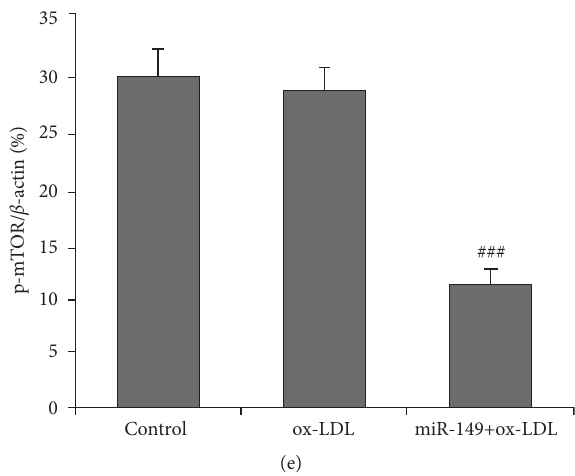
Figure 3: miR-149 mimics enhance autophagy through inhibiting the Akt/mTOR pathway. (a) Western blot was performed to determine Akt and mTOR proteins. Compared to HUVECs with ox-LDL (100 μ g/mL), expressions of Akt (b), p-Akt (c), mTOR (d), and p-mTOR (e) were significantly reduced by miR-149 mimics treatment. Calculation of all these proteins was normalized to β -actin. RT-qPCR was used to determine the mRNA expression of AKT. ∗∗∗ P < 0 . 001 vs. ox-LDL group.